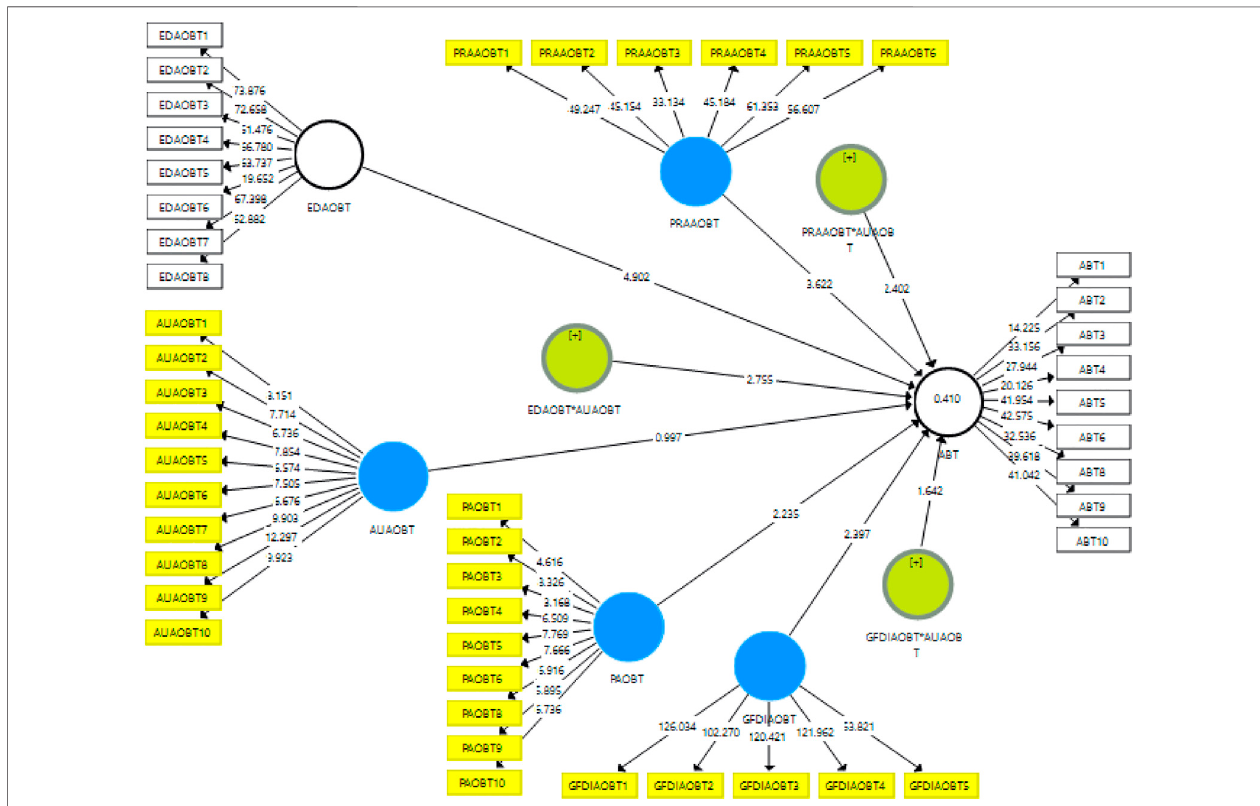
FIGURE 3 | Structural model